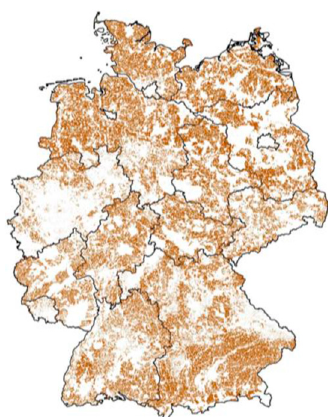
Figure 3. Results of land eligibility investigation of Germany. Sites that are suitable for wind turbine are shown in brown (113,126 km 2 ), while areas that are inaccessible due to poor land cover, protected regions, or being too close to roads and buildings are shown in white (244,043 km 2